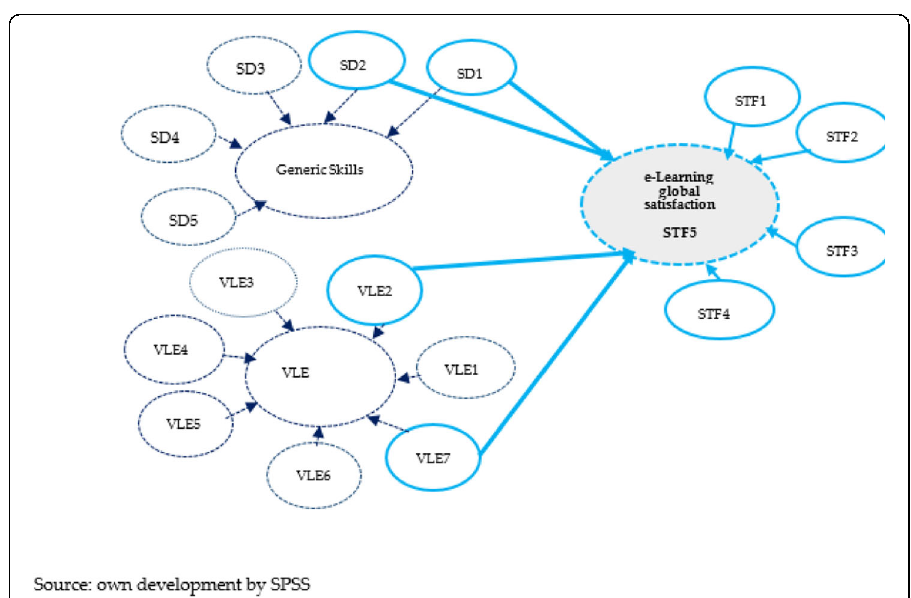
Fig. 3 Model for global satisfaction (STF5): R5